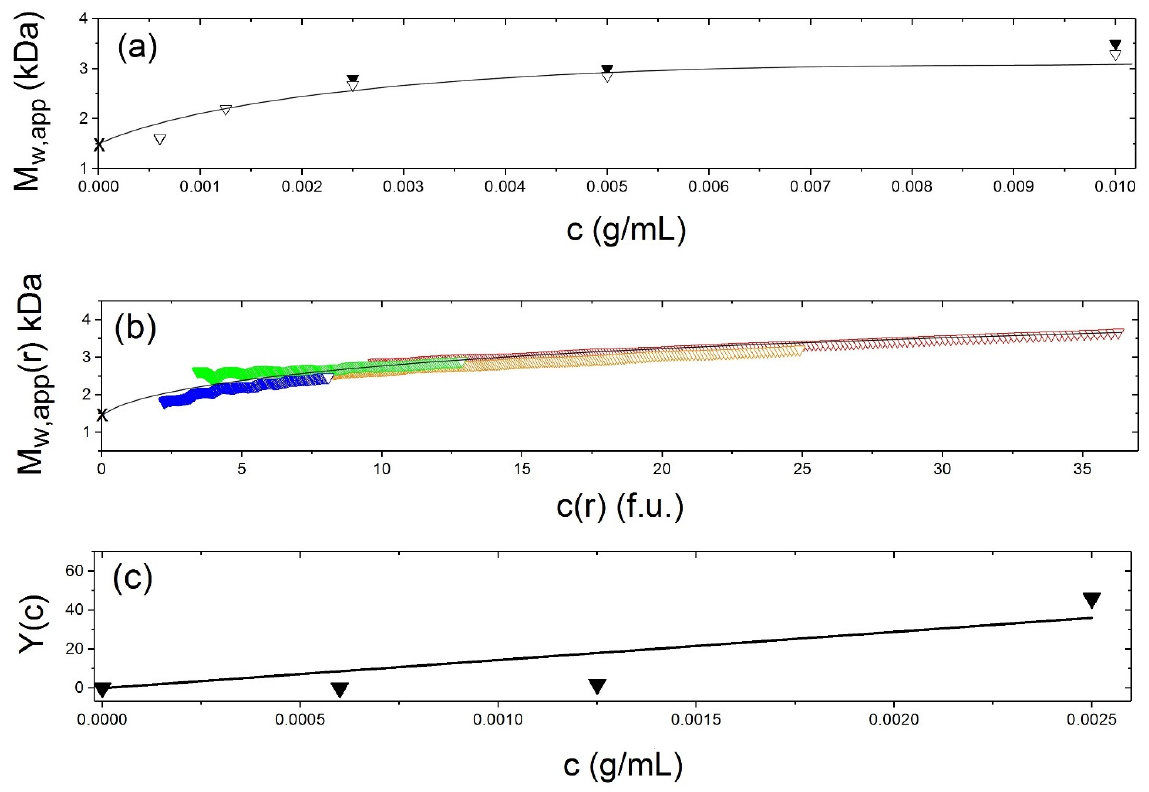
Figure 6. Sedimentation equilibrium dimerisation analysis of vancomycin. Solvent 0.9% NaCl at 7.0 ◦ C. using ( a ) Change of weight average molecular mass M w of vancomycin with loading concentration. Solid triangle—molecular masses M w,app obtained from M * analysis using SEDFIT-MSTAR [37]. Open triangles—molecular masses obtained by hinge point analysis also using SEDFIT-MSTAR. ( b ) Diagnostic plots confirming a completely reversible dimerisation. Weight average molecular masses M w ( r ) at individual radial positions in the ultracentrifuge cell plotted against local concentration c ( r ) in interference fringe units for different loading concentrations: blue (1.25 mg/mL), green (2.5 mg/mL), orange (5.0 mg/mL) and red (10.0 mg/mL). For a completely reversible association the plots should lie, within experimental error, on the same curve. ( c ) Evaluation of the association constant k 2 and corresponding molar dissociation constant K d and standard Gibbs free energy change G o from the Kegeles-Rao equation [21,53,54]: Y ( c ) ≡ M 1 { M w ( c ) − M 1 }/{(2 M 1 − M w ( c )) 2 } = k 2 . c, where the M w ( c ) are the weight average molecular masses (averaged over whole macromolecular distributions) at different loading concentrations, c . k 2 = (14,400 ± 3600) mL/g, K d = (40 ± 10) μ M and G o = (23.3 ± 0.6) kJ/mol. Because of the low molecular masses non-ideality effects can be assumed negligible and M w , app = M w in ( a )–( c ). For corresponding analyses in other solvent conditions see [4]. Adapted from Phillips-Jones et al. [4] and reproduced by permission from the Nature Publishing Group.